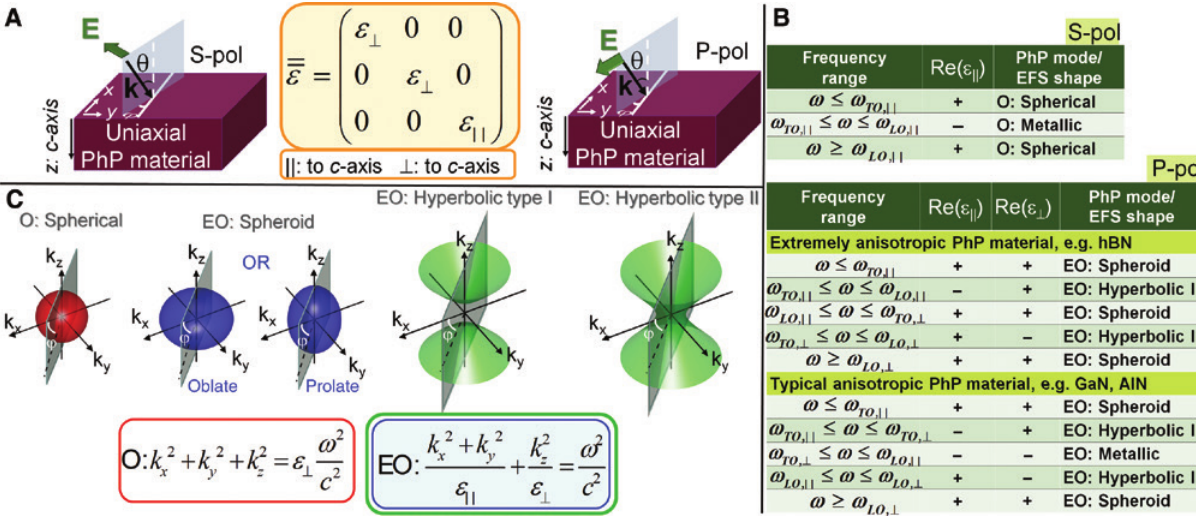
Figure 15: Photonic responses for uniaxial PhP media.